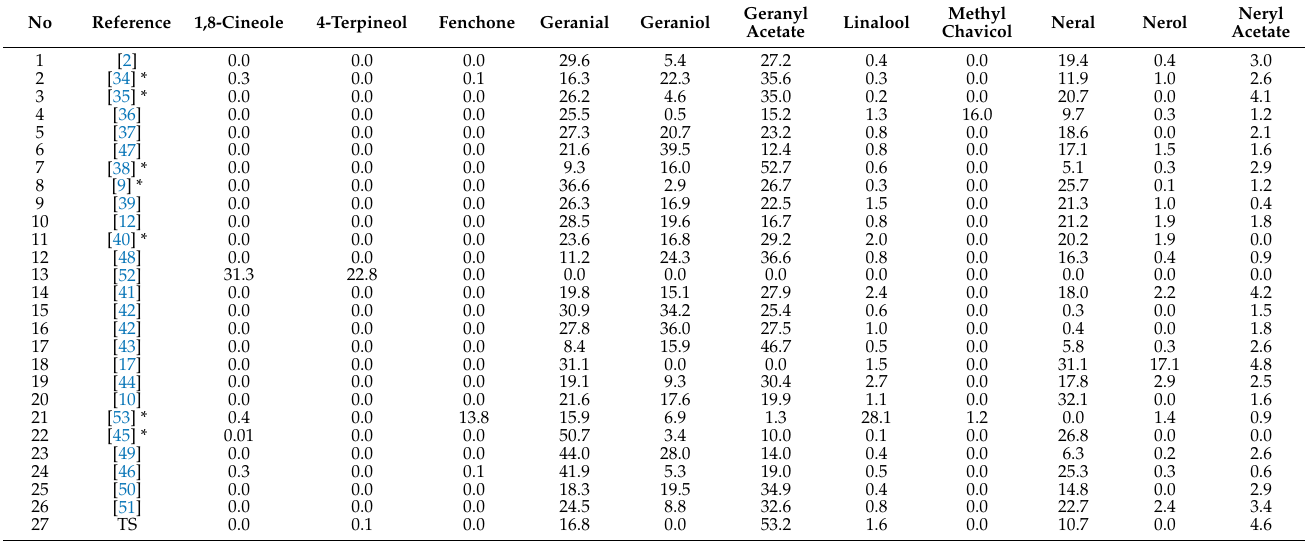
Table 8. Chemical composition of DMEO according to the literature